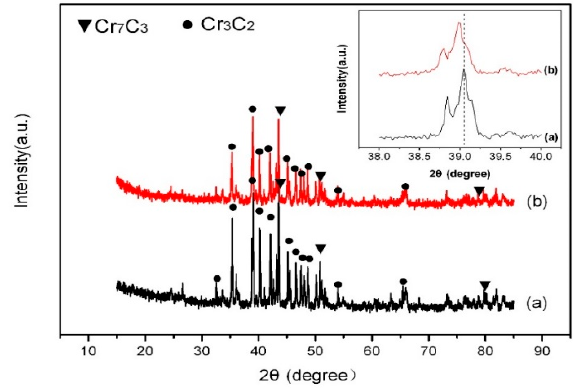
Figure 4. XRD patterns of the powders (1000 °C, 1 h) before and after gamma ray irradiation: ( a ) before gamma ray irradiation; ( b ) after gamma ray irradiation. The insertion is an enlargement of the diffraction peaks of the products at 38–40°.